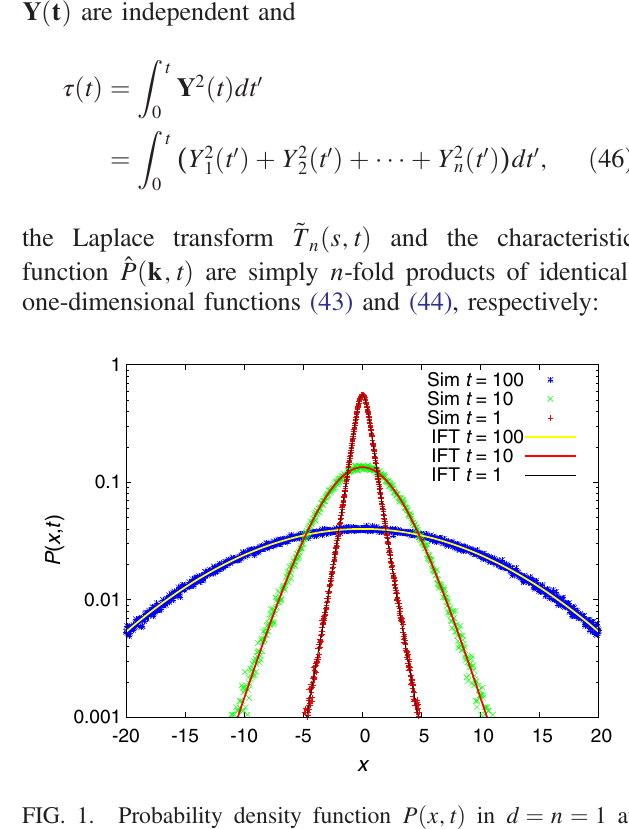
FIG. 1. Probability density function P ð x; t Þ in d ¼ n ¼ 1 at longer times in dimensionless form ( σ ¼ τ ¼ D ⋆ ¼ 1 ). We compare results from simulations (Sim) of the set of Langevin equations (20a) – (20c), represented by the symbols, with the direct inverse Fourier transform (IFT) of result (44). Excellent agreement is